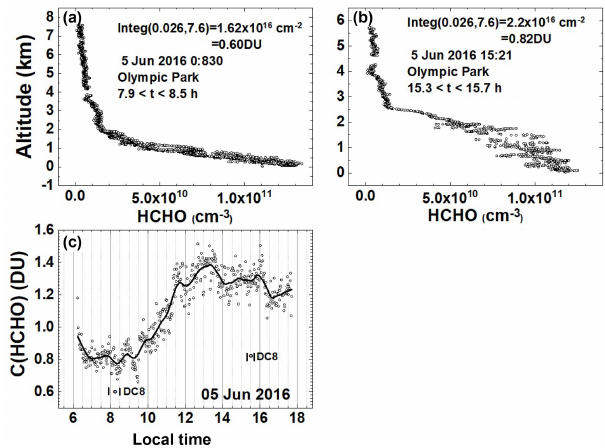
Figure 16. HCHO altitude profiles measured by CAMS onboard the DC-8 on 5 June at 08:30KST (a) and 15:21KST (b) over Olympic Park, Korea. (c) PSI measurements of total column HCHO. Vertical bars mark the DC-8 flight duration for the profiles yielding column amounts of 0.60 and 0.82DU.